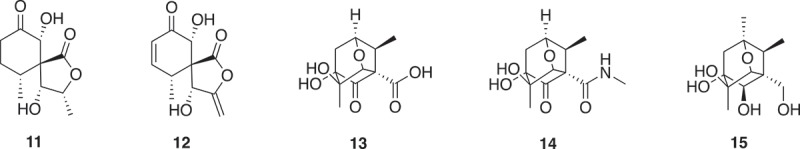
Compounds (11–15) obtained by derivatization of massarigenin.